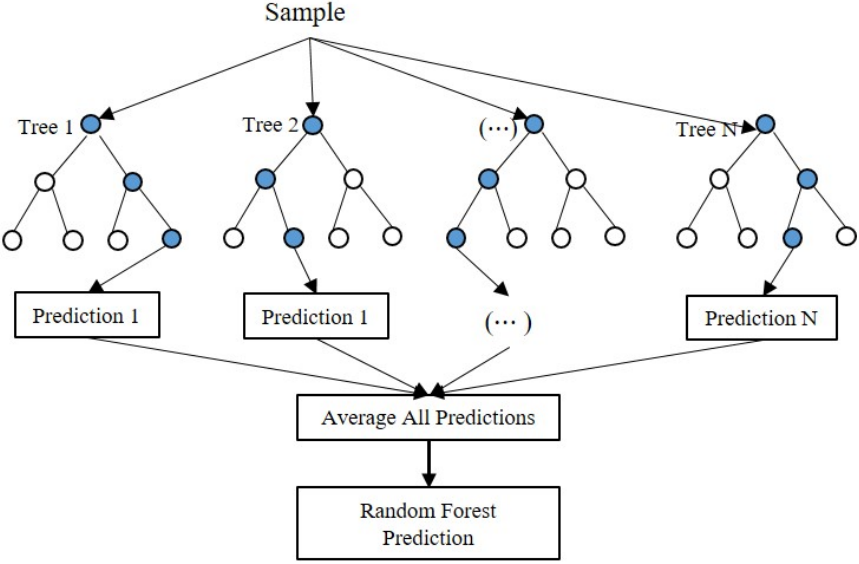
Figure 11. The general structure of a random forest.